Question: What style of plot is this figure drawn as?
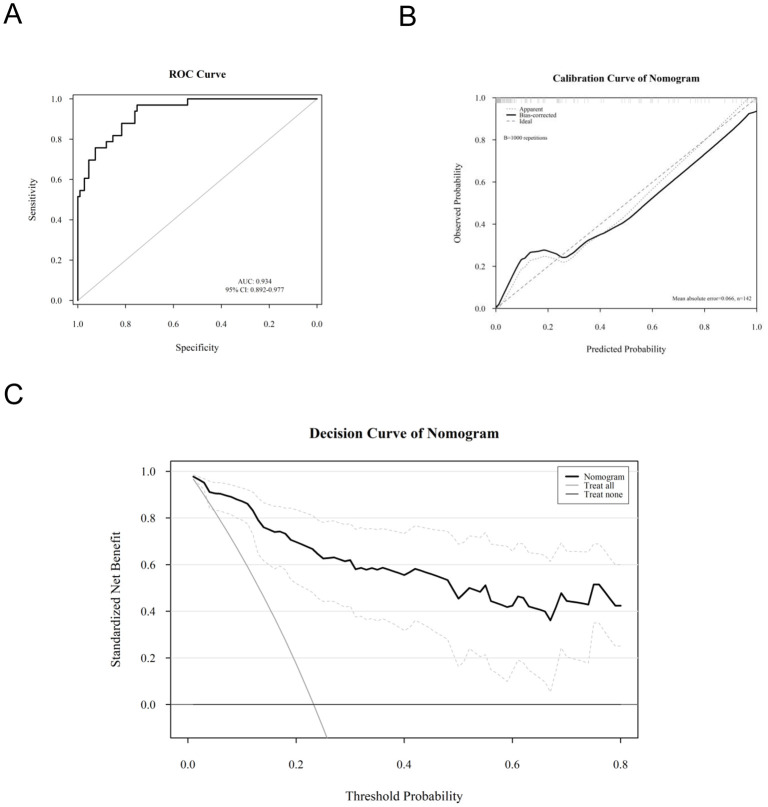
Answer: line